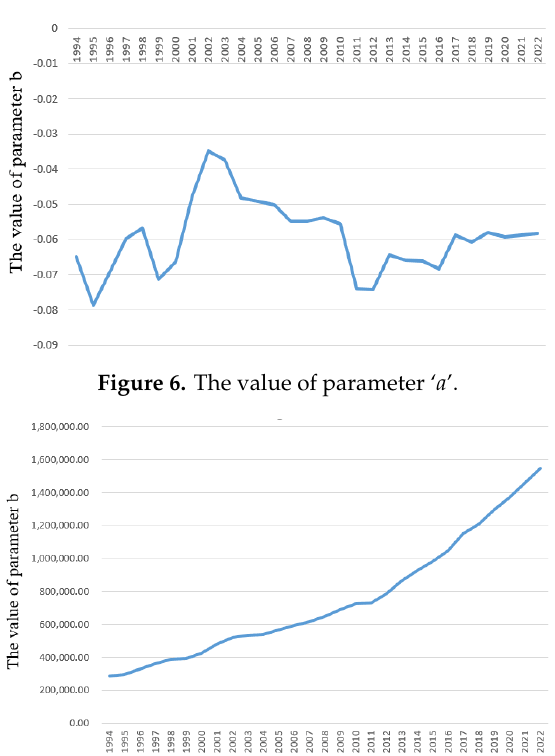
Figure 5. the cyclic mode of the MGM (1,1) model.